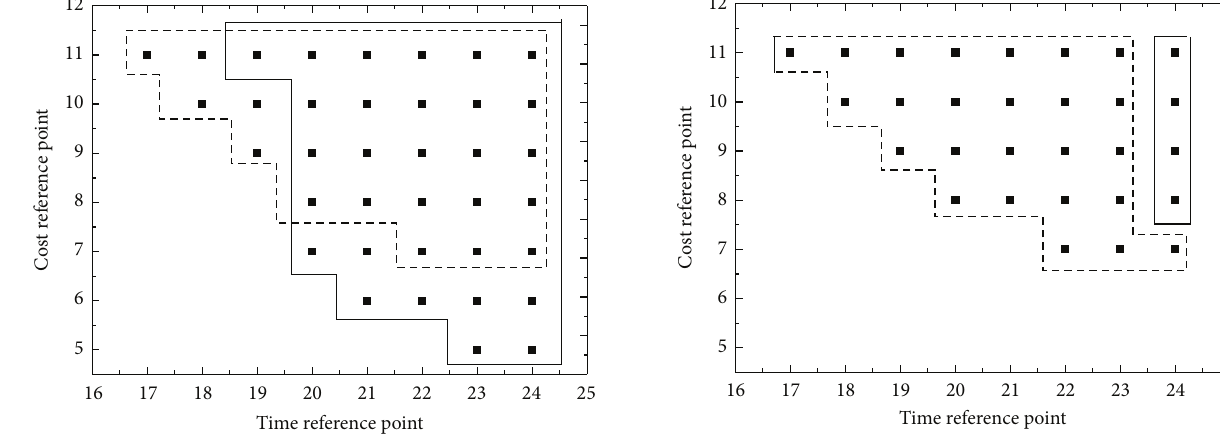
Figure 9: Possible reference points of carpooling success with detour distance 2.5km.